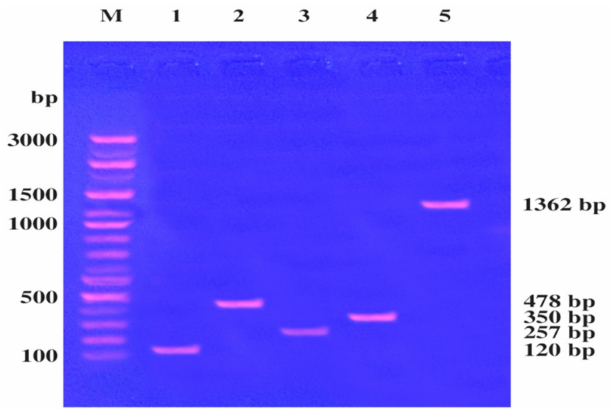
Figure 3. Detection of S. aureus B3 virulence factors in two multiplex PCR reactions; DNA marker (M), sea (1), seb (2), sec (3), tsst-1 (4), and fnbA (5).